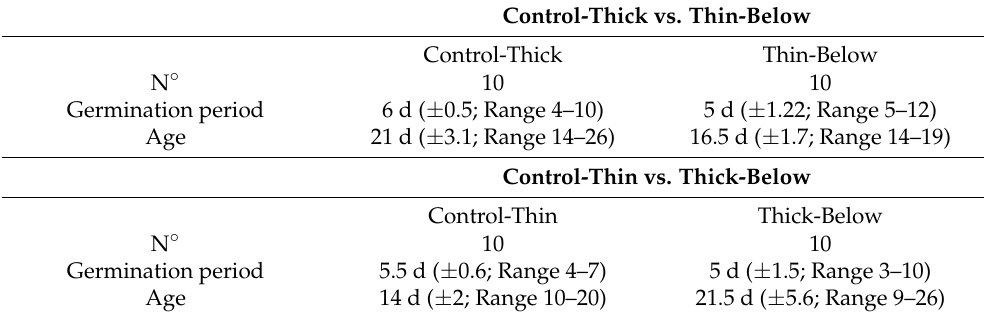
Table 1. Sample description.